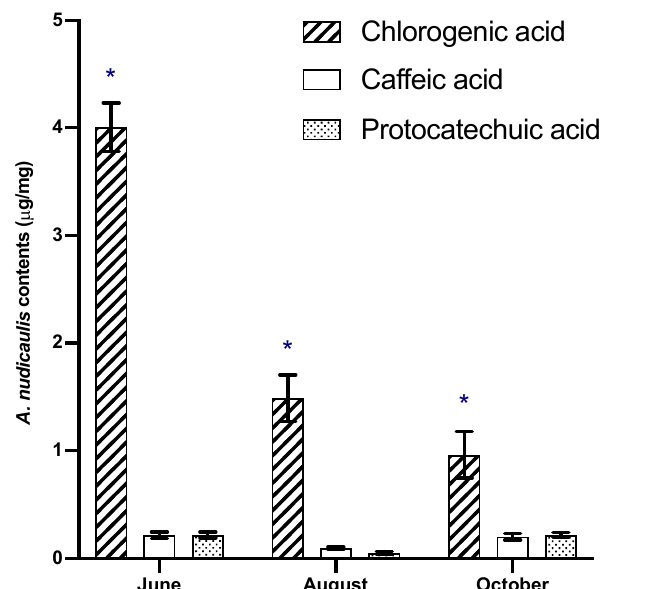
Figure 2. HPLC quantitative pattern of the three main phenolic acid (mean ± SD): chlorogenic acid (ChA), caffeic acid (CA) and protocatechuic acid (PA) during the growing season of A. nudicaulis L. Significative differences of each phenolic acids between the vegetation stages are indicated by (*) according to Duncan’s test ( p < 0.05).